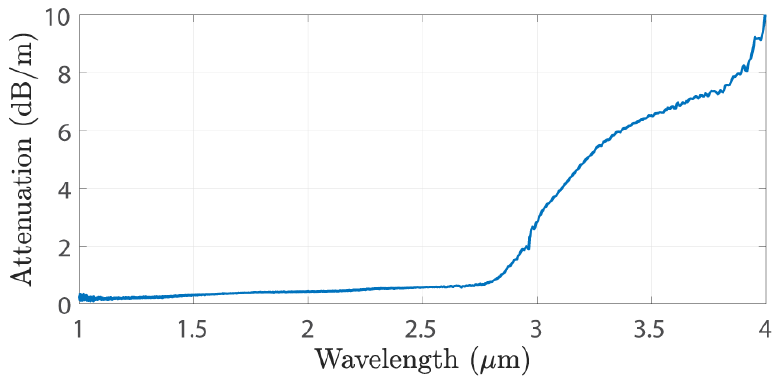
Figure 2. Large-core (TZNF/TZNG) fiber losses measured by means of the cutback method.